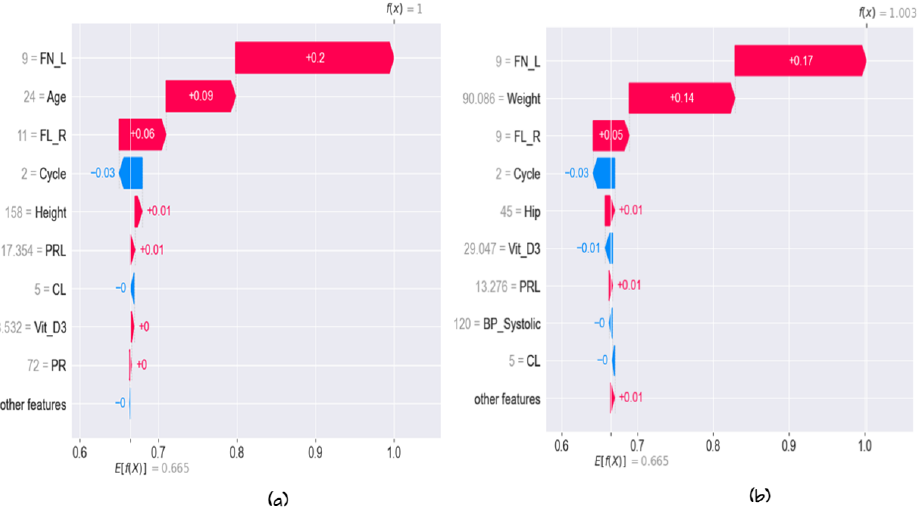
Figure 12. Full water plot for the first and second observation: ( a ) first observation; ( b ) second obser- vation.